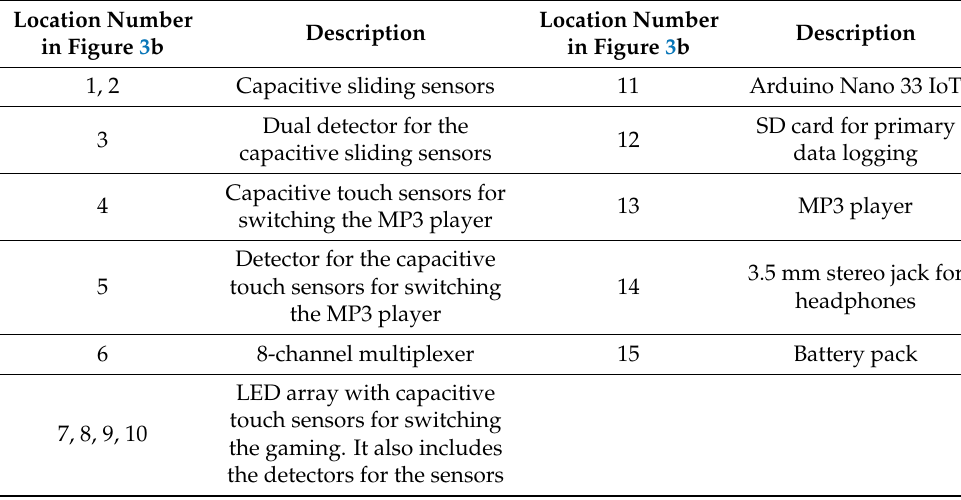
Table 1. Component list of the underlying technological layer in Figure